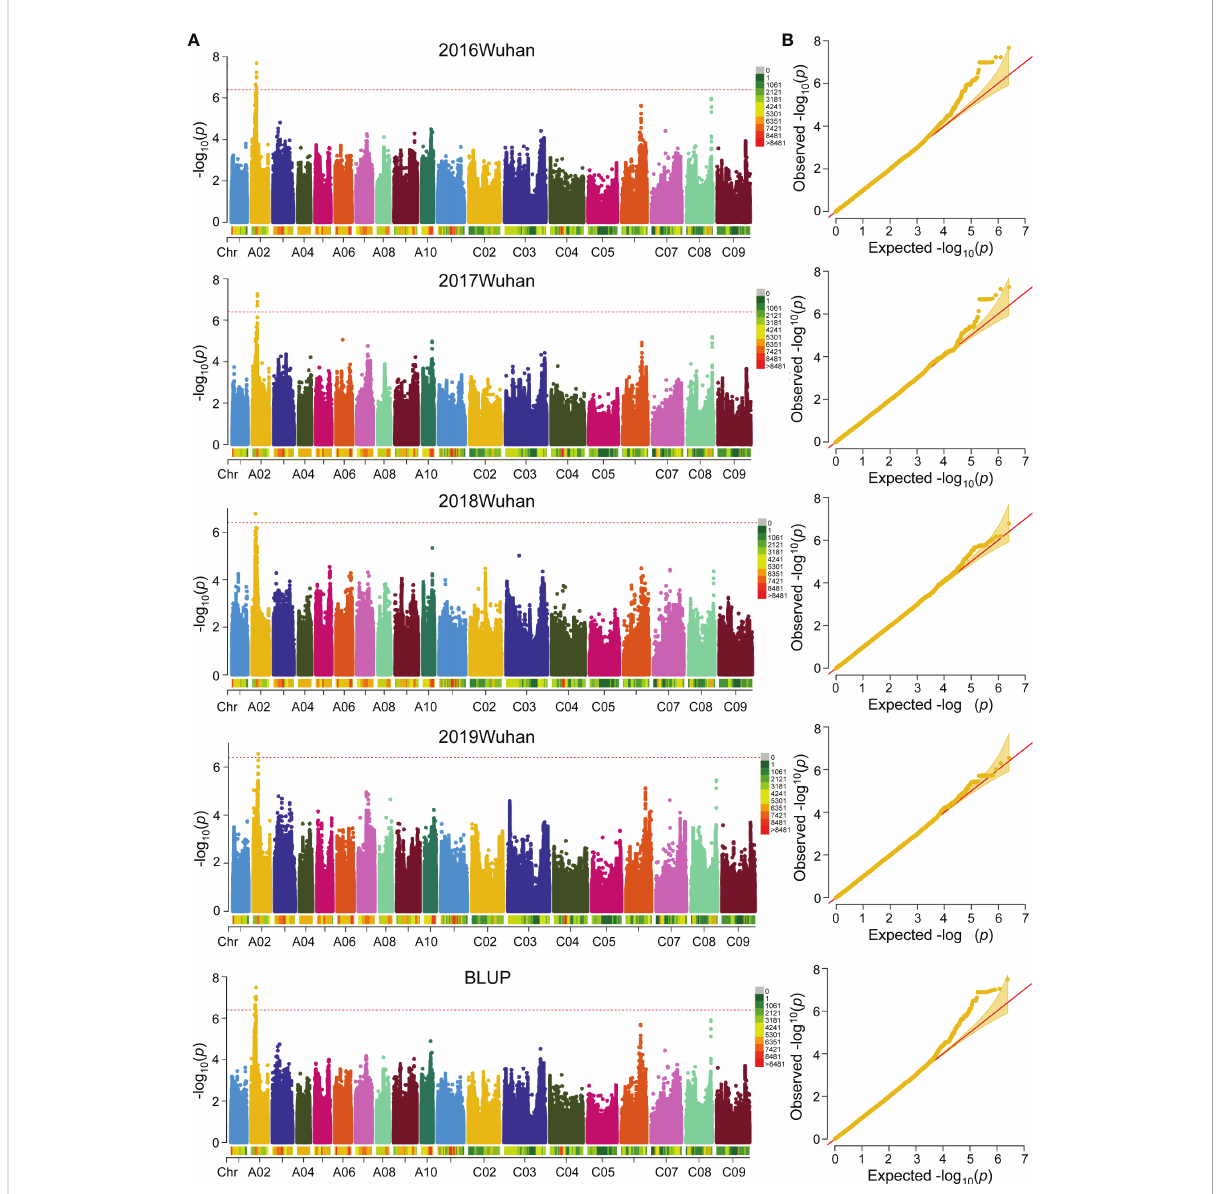
FIGURE 2 Genome-wide association study (GWAS) of FBH trait in 324 accessions. (A) Manhattan plot of FBH identi fi ed by GWAS in four consecutive years and BLUP based on a mixed linear model (MLM) of Ef fi cient Mixed-Model Association eXpedited (EMMAX). The red dotted lines and color blocks represent threshold lines and SNP number in 1 Mb window size, respectively. (B) Quantile-Quantile plot of FBH in four consecutive years and